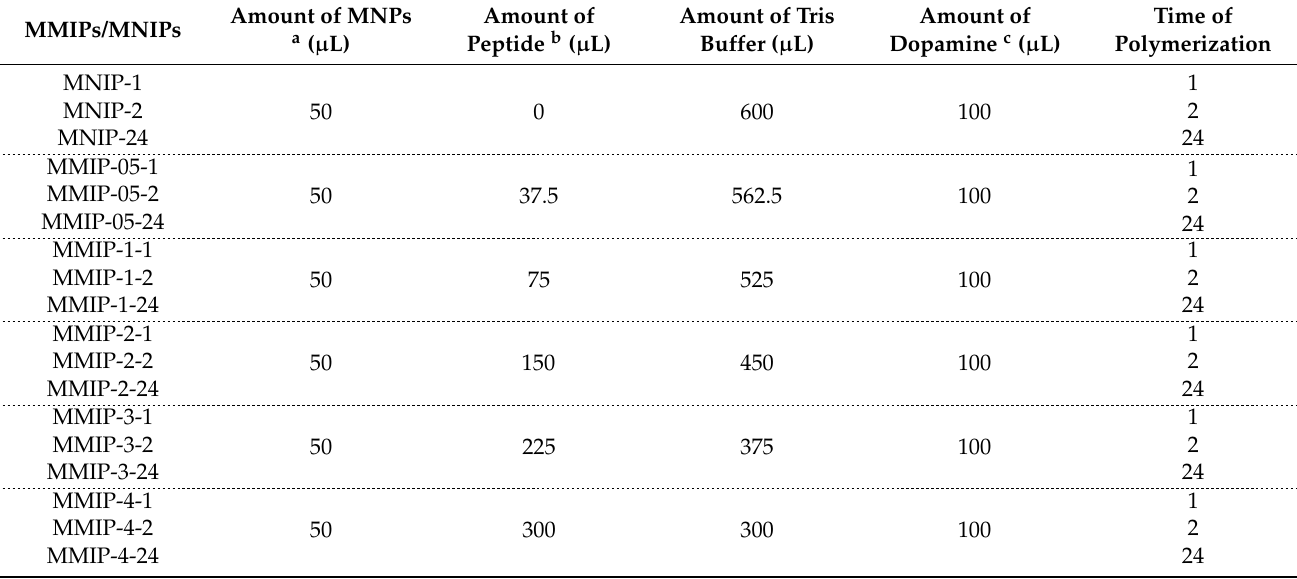
Table 3. List of prepared magnetic molecularly imprinted polymers/magnetic non-imprinted polymers (MMIPs/MNIPs) and their respective polymerization